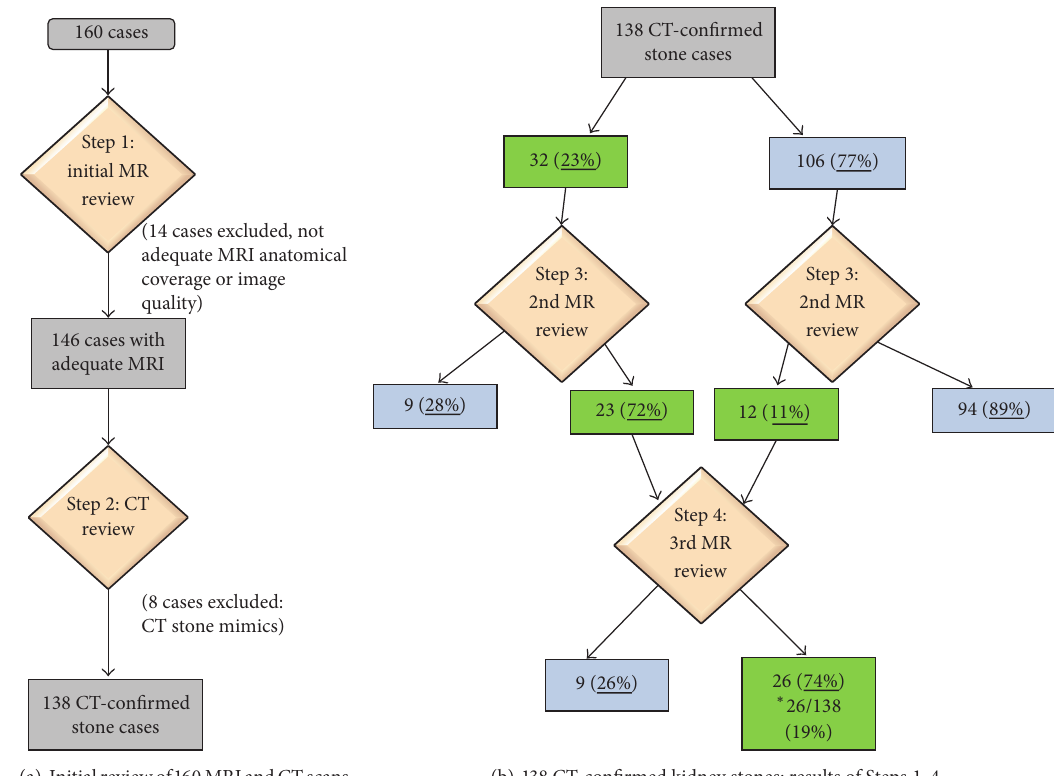
Figure 4: Study design and results. Following Steps 1 and 2, 138 CT-confirmed stones represented the included cases. Green boxes represent number and % detected by MRI at each step; blue boxes represent those not detected by MRI at each step. ∗ = overall final MRI detected